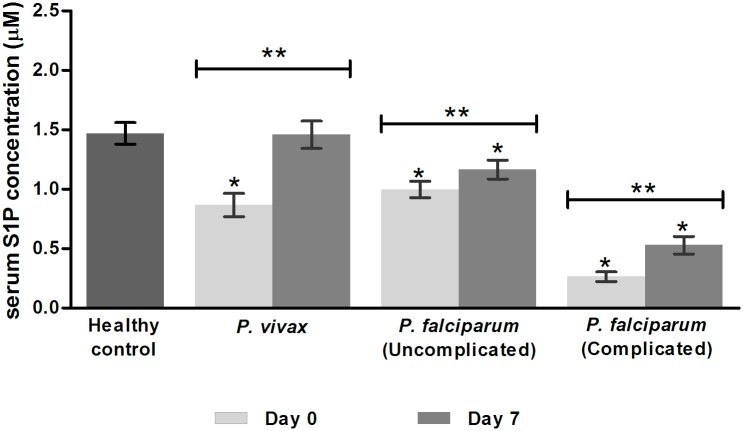
Serum S1P levels in malaria patients and healthy controls.S1P levels were measured in serum of malaria patients with P. vivax (n = 29), uncomplicated P. falciparum (n = 30) and complicated P. falciparum malaria (n = 13) on day 0 (pre-treatment) and day 7 (post-treatment) by quantitative ELISA. The healthy controls (n = 18) were used as a control group. Data are presented with mean ± SEM. *Comparison with healthy controls using Mann-Whitney U test. **Comparison between day 0 and day 7 using Wilcoxon signed-rank test.